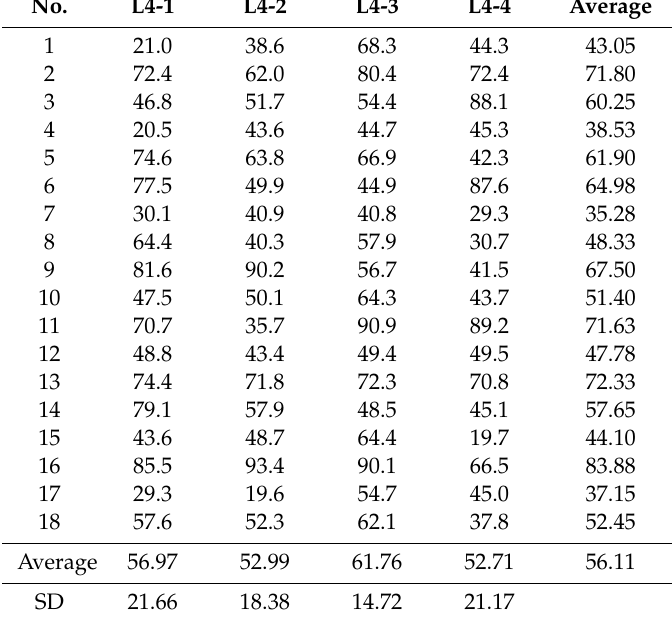
Table 4. Phase purity (%), average (%), and SD (standard deviation) of the synthesized smectites in the experimental combinations.